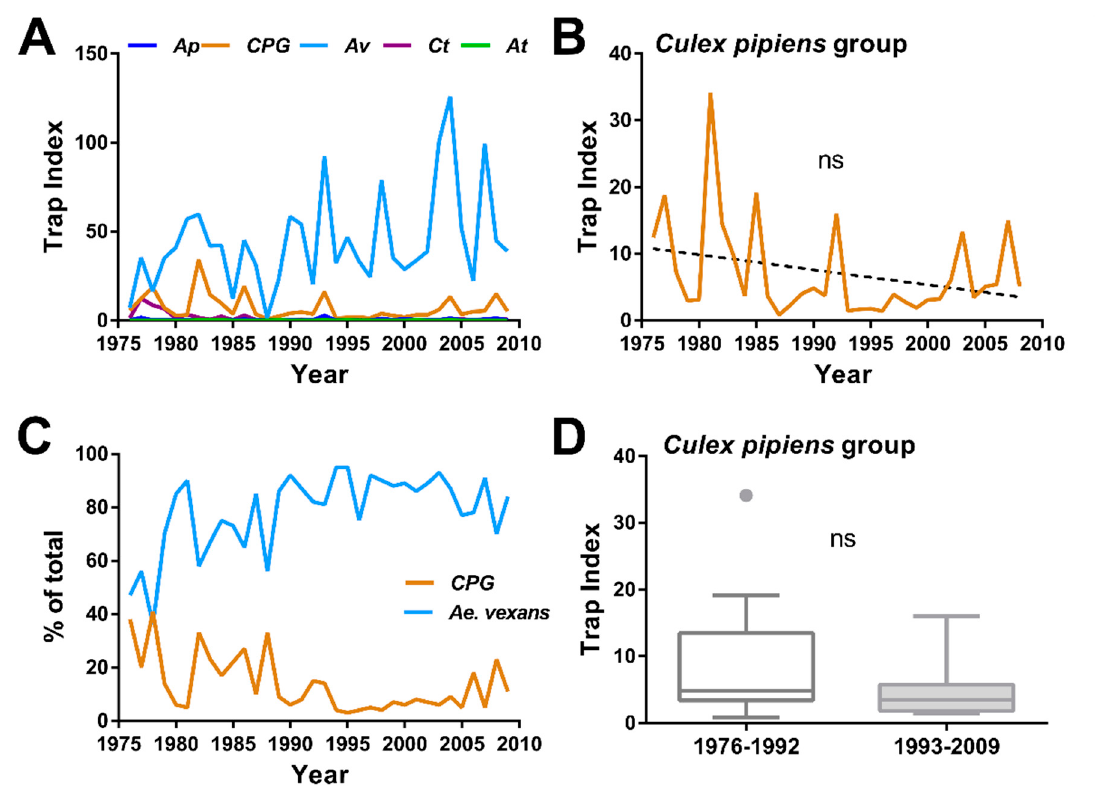
Figure 3. Temporal analysis of mosquito data from the Des Moines, Iowa trap site (1976–2009). Trap index averages (standardized counts) for each year at the Des Moines site for the five most collected mosquito species ( A ): Anopheles punctipennis ( Ap ), Culex pipiens group (CPG), Aedes vexans ( Av ), Culex tarsalis ( Ct ), and Aedes triseriatus ( At ). The relative abundance of the two most common species, Ae. vexans and CPG, are displayed over the study period ( B ). No significant differences (R 2 = 0.07793, p = 0.1099, F = 2.704, df: 1, 32) were detected in Culex pipiens group (CPG) populations over time using